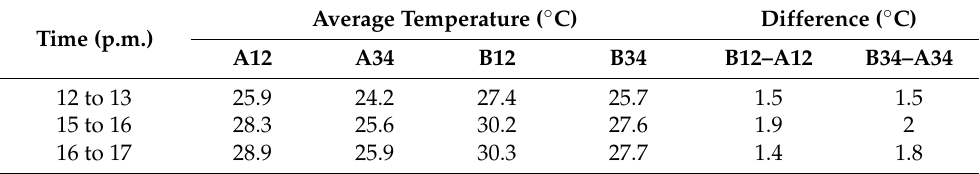
Table 3. Average and difference of the indoor temperature at different time sections. Time (p.m.)